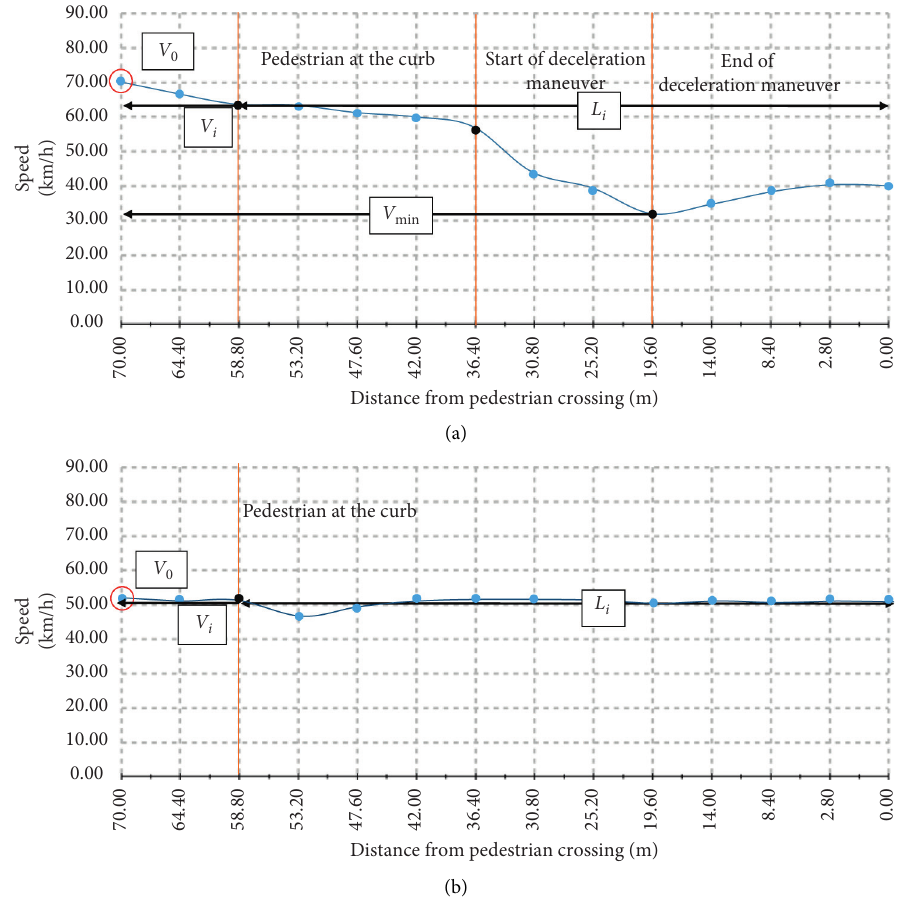
Figure 4: Dependent variables extracted from speed profiles: (a) yield to pedestrian event; (b) not yield to pedestrian event.